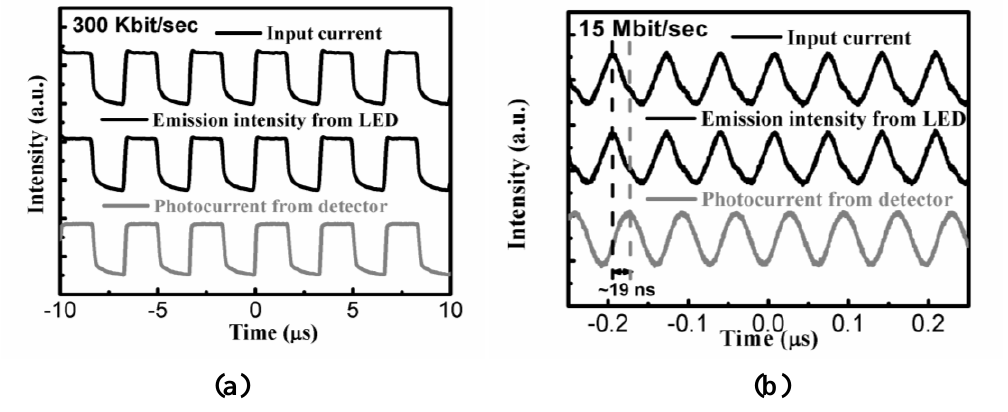
Figure 17. Modulation results of the data communication using a Ge MIS photodetector and a Ge MIS LED with a frequency of (a) 300 Kbit/sec; (b) 15 Mbit/sec. A delay time of ~19 ns was observed in (b). Reprinted from [55] with permission of the American Institute of Physics (Copyright